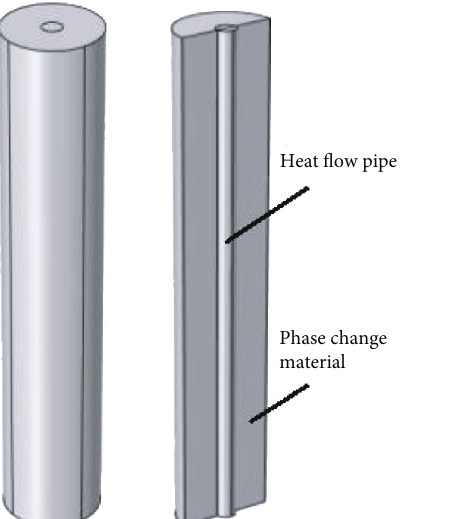
Figure 4: A phase change heat storage device shown schematically.